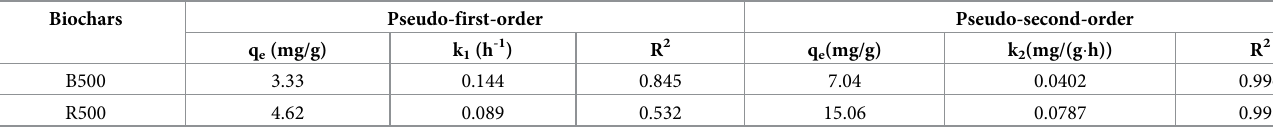
Table 2. Kinetic parameters for the adsorption of BR46 onto biochars.